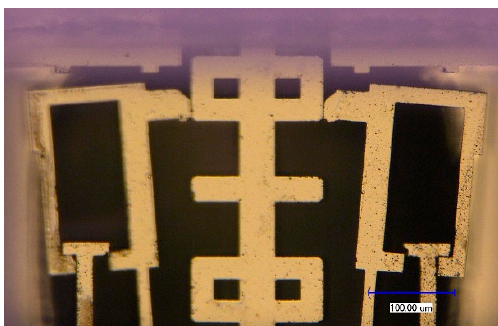
Figure 7. The pawls are stuck with the slider due to the inaccurate voltage input.